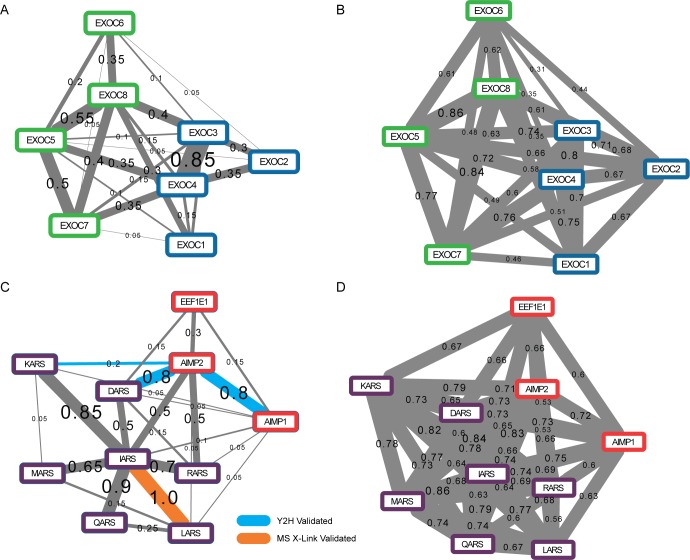
Prediction of direct contacts within human protein complexes of unknown structure.Direct contacts and correlation coefficients were calculated between 8 members of the human exocyst complex (A: direct contacts, B: correlation) and 10 members of the tRNA multi-synthetase complex (C: direct contacts, D: correlation). Contact predictions are visualized here by drawing each direct contact prediction or correlation prediction as an edge connecting the relevant subunits. Each predicted direct contact is associated with its prediction score, which indicates the stability support for that interaction. In both complexes, certain direct interactions are strongly supported, suggesting key contacts formed in the three-dimensional organization of these complexes, neither of which has yet been resolved. The comparison between direct contact predictions and correlation predictions indicates that the graphical model removes edges considered conditionally independent from the direct contact network providing high confidence predictions. For A and B, colors (blue and green) represent known sub-complexes from Heider et al. [54]. For C and D, red represents structural subunits and purple represents synthetases.